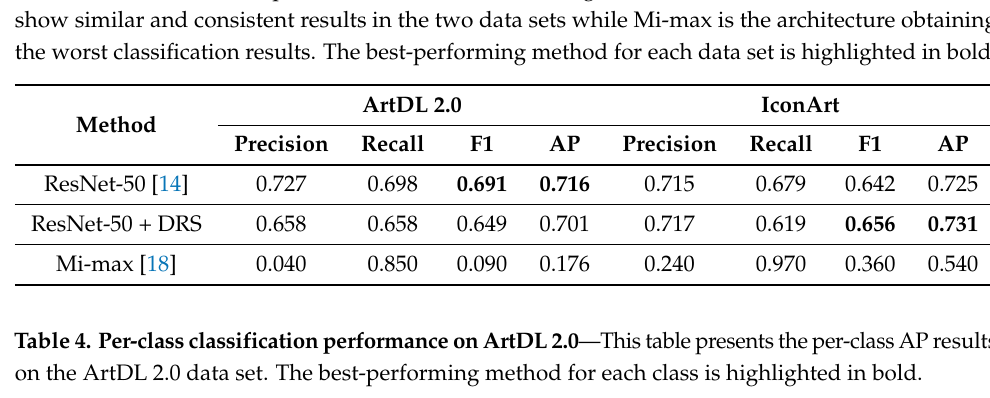
Table 3. Classification performance —This table presents the classification results on the ArtDL 2.0 and IconArt data sets. Reported results are macro-averaged. ResNet-50 and ResNet-50 with DRS show similar and consistent results in the two data sets while Mi-max is the architecture obtaining the worst classification results. The best-performing method for each data set is highlighted in bold.